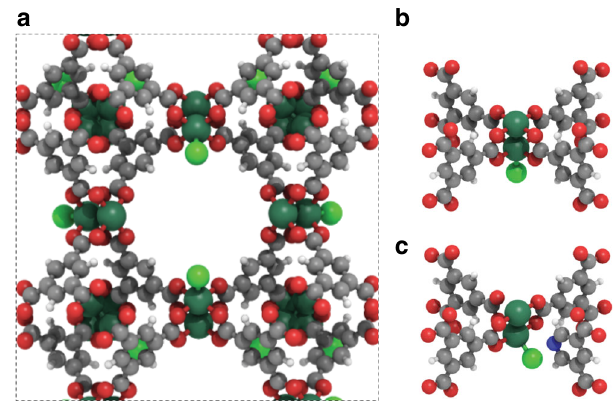
Fig. 1 Structure of (Ru)HKUST-1 metal – organic framework. a Periodic structure of pristine (Ru)HKUST-1 with a pore size of 1.5 nm. b Paddle- wheel node of pristine (Ru)HKUST-1. c Paddle-wheel node of defective (Ru)HKUST-1. (Ru = dark green, Cl = green, O = red, N = blue, C = grey, H =